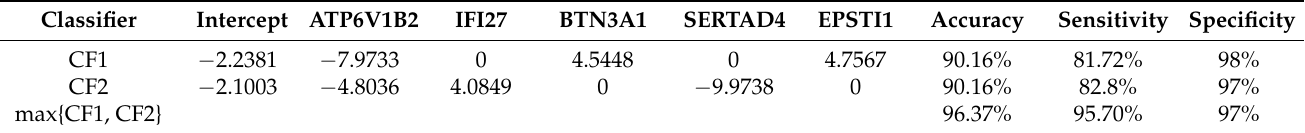
Table 5. First dataset: Characteristics of the top-performing five-gene classifier. CF1 and CF2 are the first and second individual classifiers for data of COVID-19 patients vs. non-viral infection ARI